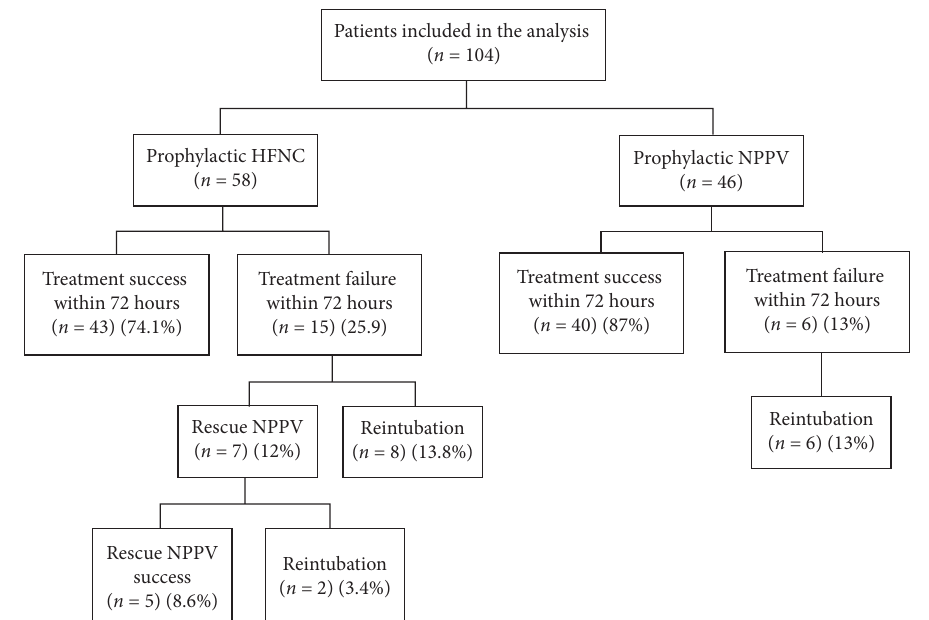
Figure 2: Outcomes following extubation within 72 hours. In the HFNC group, eight patients required immediate reintubation once treatment failure developed, and the other seven patients used NPPV as rescue therapy. Rescue NPPV successfully avoided reintubation in five patients, but it failed in two patients. In the NPPV group, six patients needed reintubation because of treatment failure. HFNC, high- flow nasal cannula; NPPV, noninvasive positive pressure